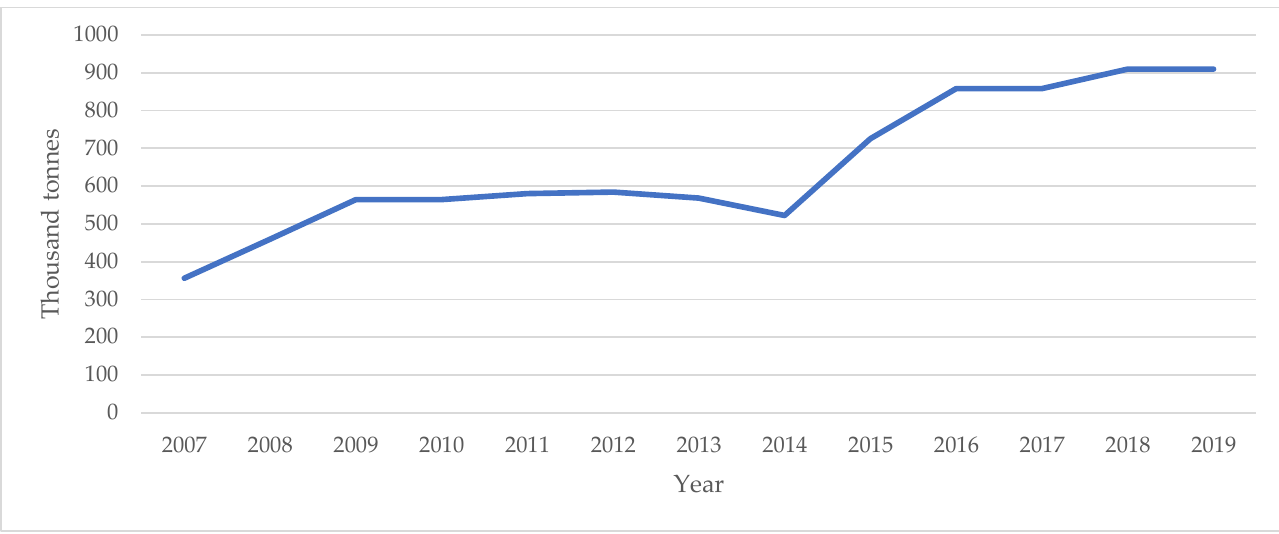
Figure 3. Pure biodiesel production in EU in 2019 (thousand tons). Source: own elaboration based on Eurostat data [55].